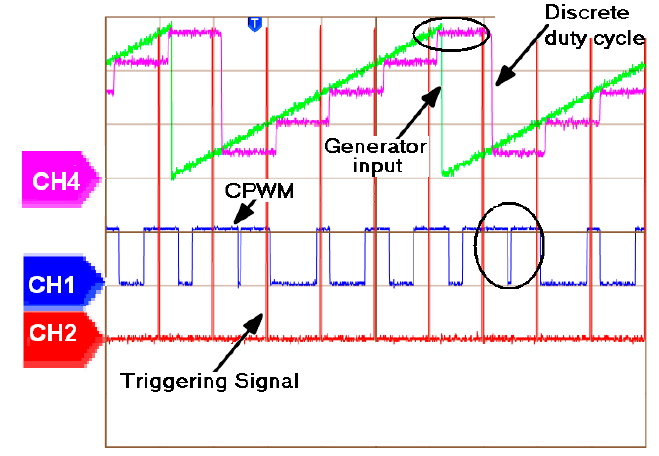
Figure 12. Generation of the CPWM signal with one delay period (1Tp).